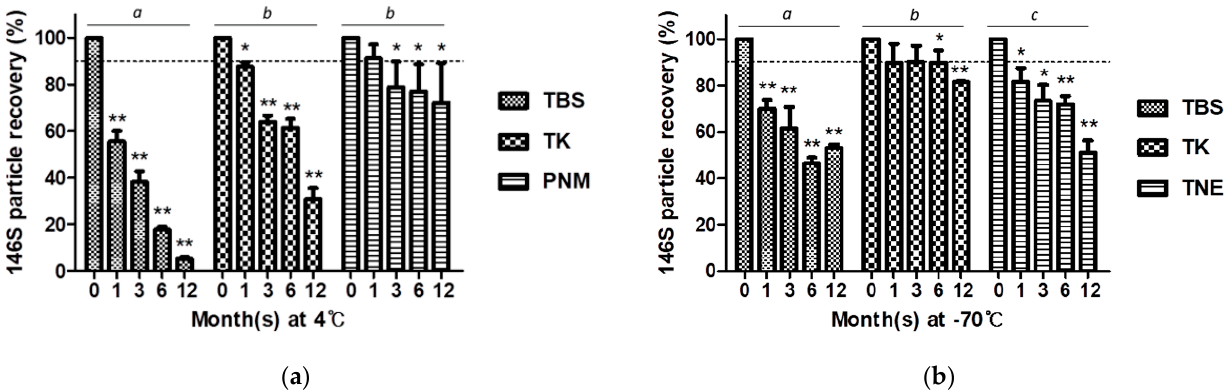
Figure 3. Effectivity of buffers for long-term storage of FMDV O JC vaccine antigen. ( a ) The 146S particle recovery (%) in each buffer during 1-year storage at 4 °C; ( b ) The 146S particle recovery (%) in each buffer during 1-year storage at − 70 °C. The dotted line is set at 90% recovery. *, p < 0.05, **, p < 0.01. Different lowercase letters indicate significant differences at p < 0.05.